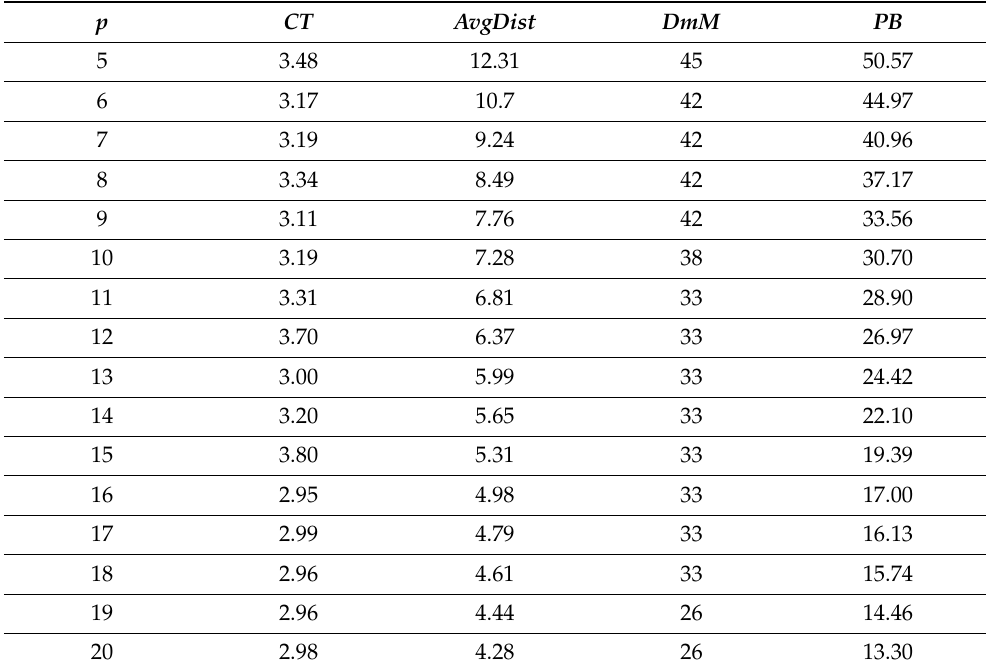
Table 1. Results of numerical experiments with the location-allocation model (1)–(6) using the dataset for the self-governing region of Žilina.